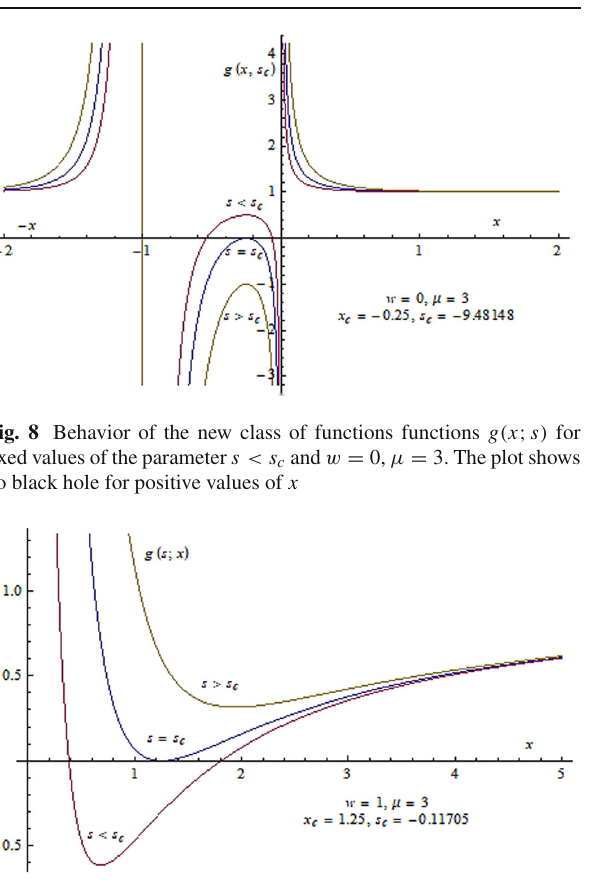
Fig. 9 Behavior of the new class of functions functions g ( x ; s ) for fixed values of the parameter s < s c and w = 1, μ = 3. The plot looks like showing horizons for positive values of x but is based on inadmissible s <